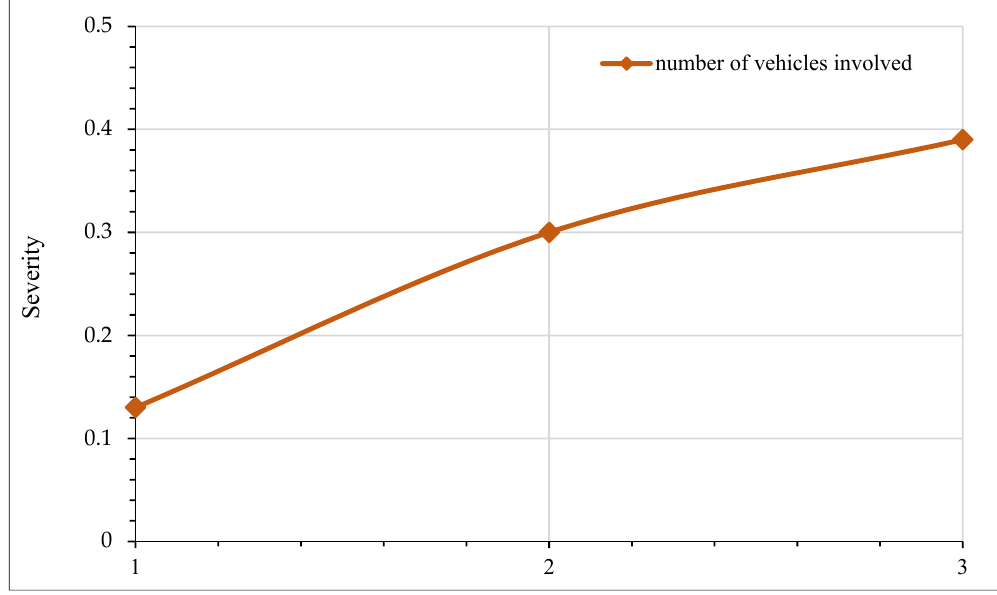
Figure 7. Effect of the number of vehicles involved in crash severity. Figure 7. E ff ect of the number of vehicles involved in crash